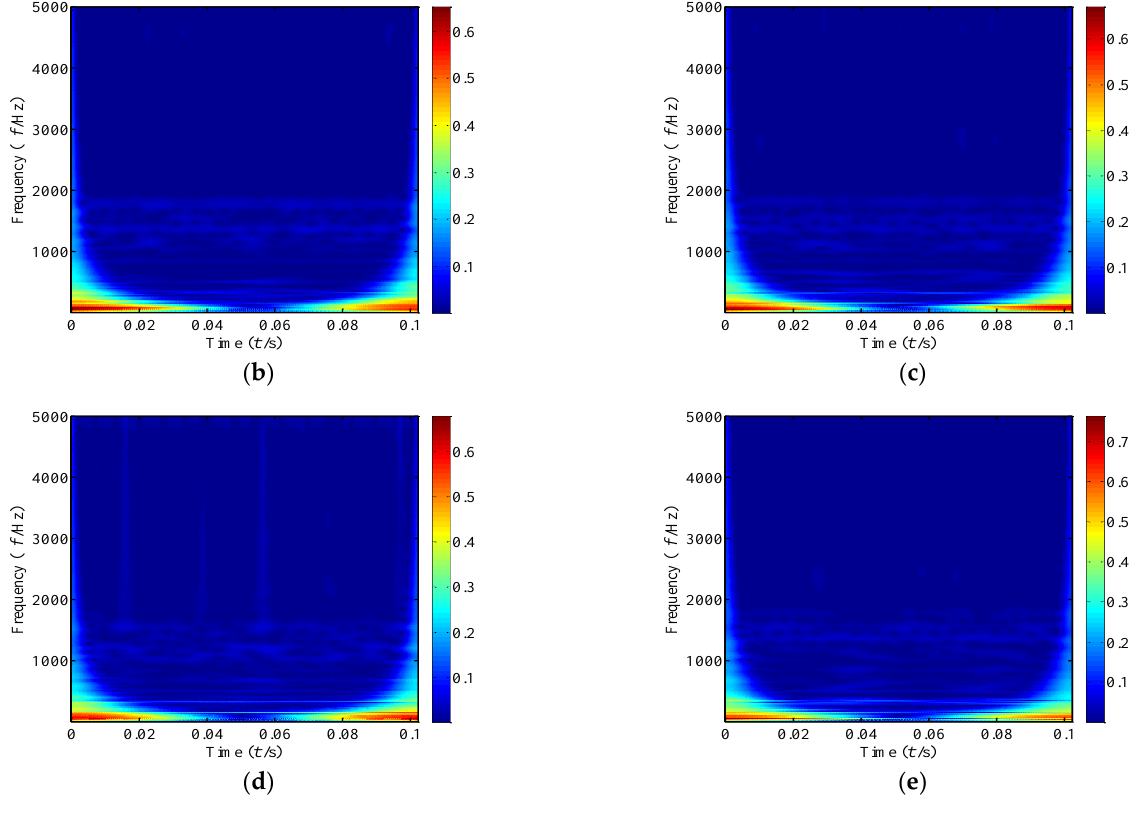
Figure 10. Time–frequency distributions of pressure signal via continuous wavelet transform. ( a ) Normal condition, ( b ) wear of the slipper, ( c ) failure of the loose slipper, ( d ) wear of the swash plate, ( e ) wear of the central spring.